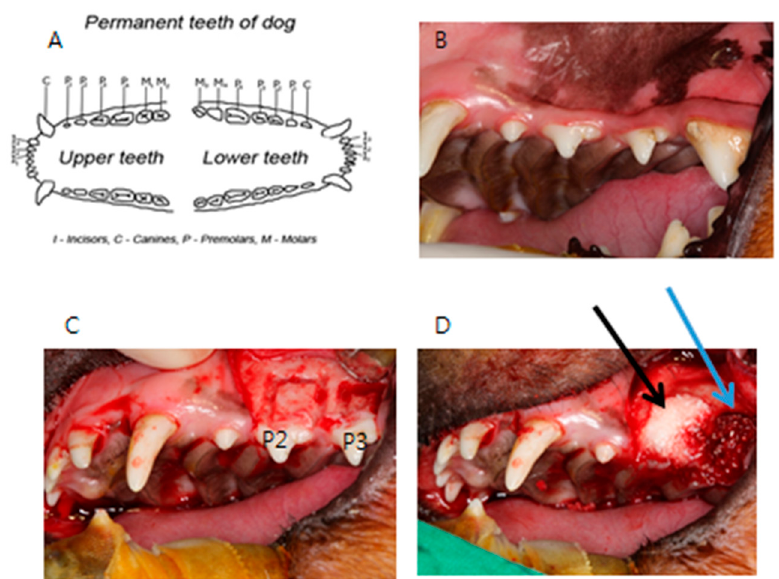
Figure 2. Photograph of the animal experiment. ( A ) Permanent teeth of the beagle; ( B ) Intraoral photograph of the beagle; ( C ) Unilateral maxillary second (P2) and third premolars (P3) were extracted and mucoperiosteal flaps were elevated. The rectangular bone defects measuring 5 mm × 8 mm on the second and third premolars were made; ( D ) Autogenous bone was grafted onto one of two bone defects (control group, blue arrow), and human DDM fixed with rhBMP-2 was grafted onto the other (experimental group, black arrow).